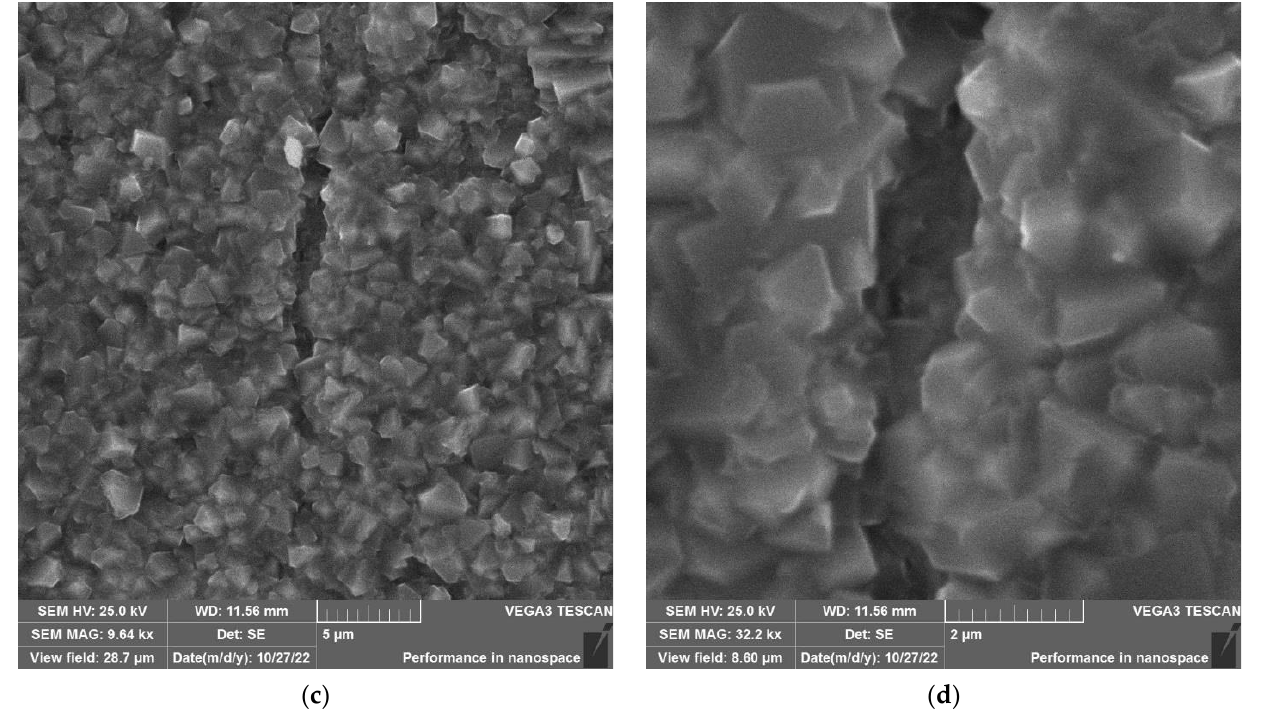
Figure 11. Surface of disk specimen № 10 (T irr = 550 °C, Table 4) at different magnifications after autoclave SCC tests with a load value of 650 N (before crack opening loading).